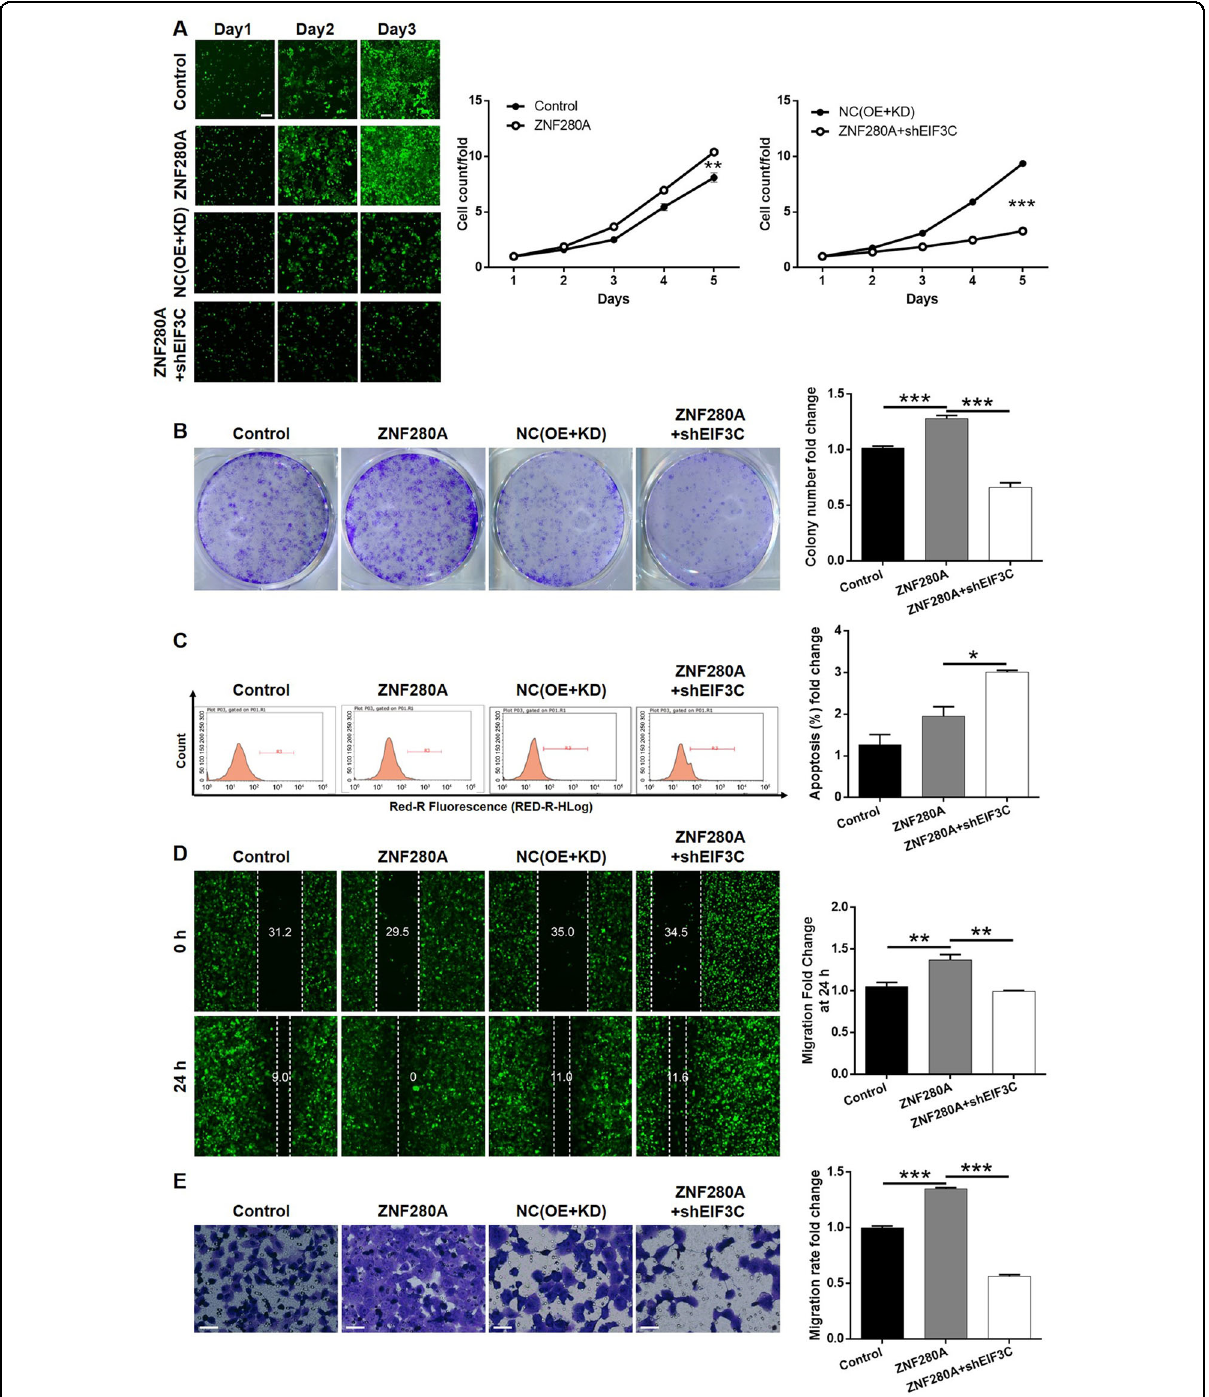
Fig. 6 Knockdown of EIF3C attenuated the effects of LUAD cells by ZNF280A overexpression. NCI-H1299 cells transfected with Control plasmids, ZNF280A overexpression plasmids, NC(OE + KD), and simultaneous ZNF280A overexpression plasmids and shEIF3C were subjected to the detection of cell proliferation by Celigo cell counting assay (Scale bar = 400 μ m) A , colony formation B , cell apoptosis by fl ow cytometry C , cell migration by wound-healing assay D and cell migration by Transwell assay (Scale bar = 50 μ m) E . The representative images were selected from at least three independent experiments. Data were shown as mean ± SD. * P < 0.05, ** P < 0.01, *** P <